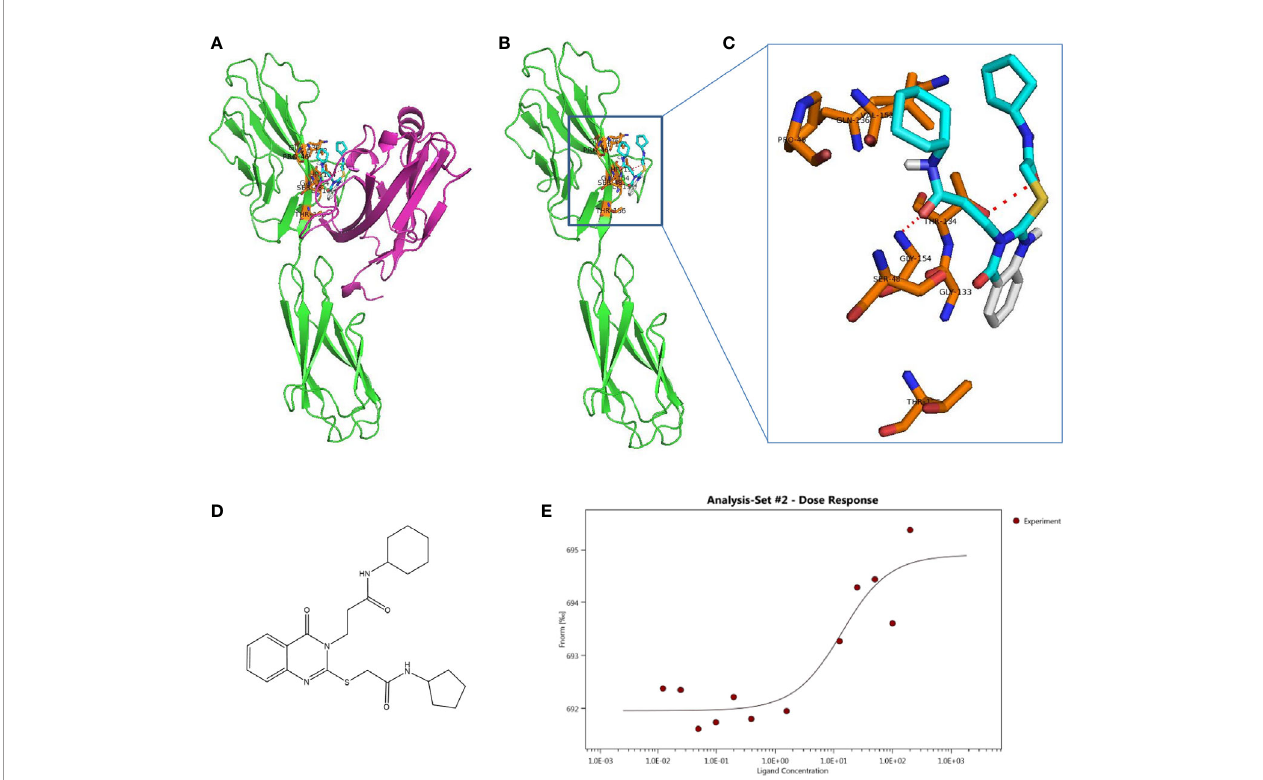
FIGURE 4 | Schematic diagram of docking structure of small molecule compound K284-3046 and VSIG3 protein. (A) K284-3046 binds to VSIG3/VISTA interface. K284-3046 (blue stick) docked superposition on VSIG3 (green)/VISTA (purple) interface. (B) Interactive amino acids (orange sticks) with K284-3046 (blue stick) on VSIG3 (red dash line indicates the hydrogen bonds). (C) VSIG3 protein extracellular domain and the docked positions of K284-3046. (D) The structure of compound K284-3046. (E) The MST assay evaluates the KD value of K284-3046 binding to VSIG3 protein. The KD value is 11.61 ± 9.12 m